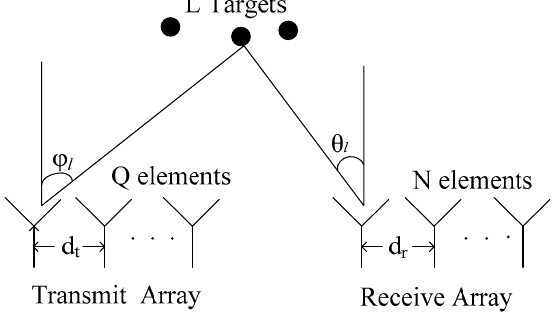
Figure 1. Bistatic multiple-input/multiple-output (MIMO) radar system .